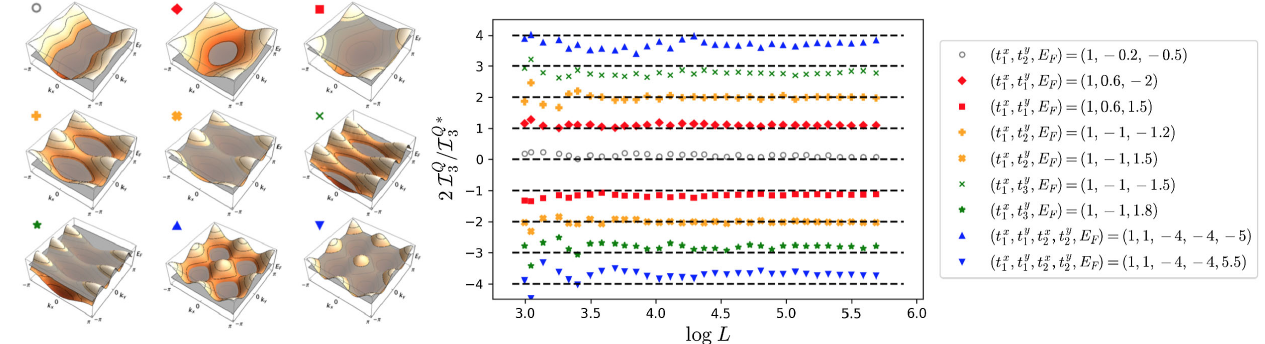
FIG. 6. Ratio analysis for nine sets of Fermi sea topology, with χ of dispersion in the square lattice tight-binding model. Shaded regions correspond to the filled Fermi sea. Middle: ratio χ (cid:5) function of linear system size L . The standard ruler f I Q (cid:5) 3 ; χ (cid:5) hence, χ (cid:5) ¼ 2 . Right: specifications of hopping integrals and Fermi energy that generate the nine sets of Fermi sea under study. F Unspecified hoppings are set to